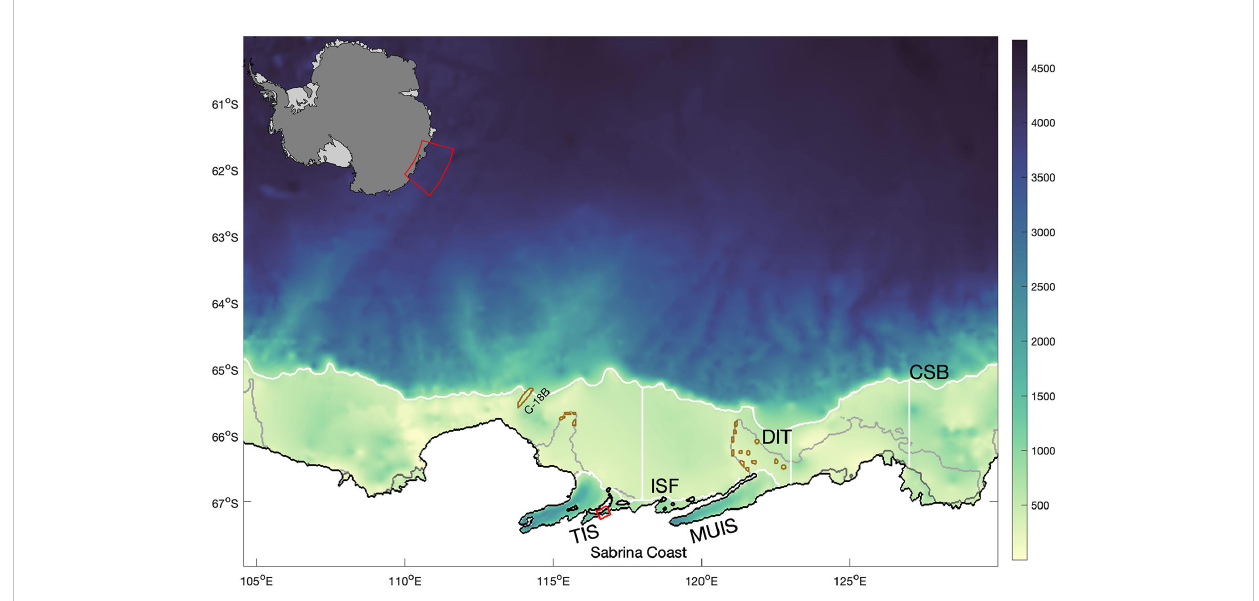
FIGURE 1 Map of the simulation domain in Wilkes Land along the Sabrina Coast with ocean bathymetry. The coastline is in black, the edge of the (prescribed) landfast sea ice is in grey. Five transects are marked by white lines: the continental shelf break (CSB) and the TIS and MUIS ice shelf fronts (ISF) are irregular contours; three longitudinal white lines across the continental shelf show the three transects from the ice shelf front to the continental shelf break at 118° E, 123° E, and 127° E. The small red square near the TIS shows the location of the inland cavity. Large iceberg C-18B and other grounded icebergs (including those comprising the Dalton Iceberg Tongue, DIT) included in the model are outlined in brown. Figure created with MATLAB Antarctic mapping tools (Greene et al., 2017b) and cmocean (Thyng et al.,